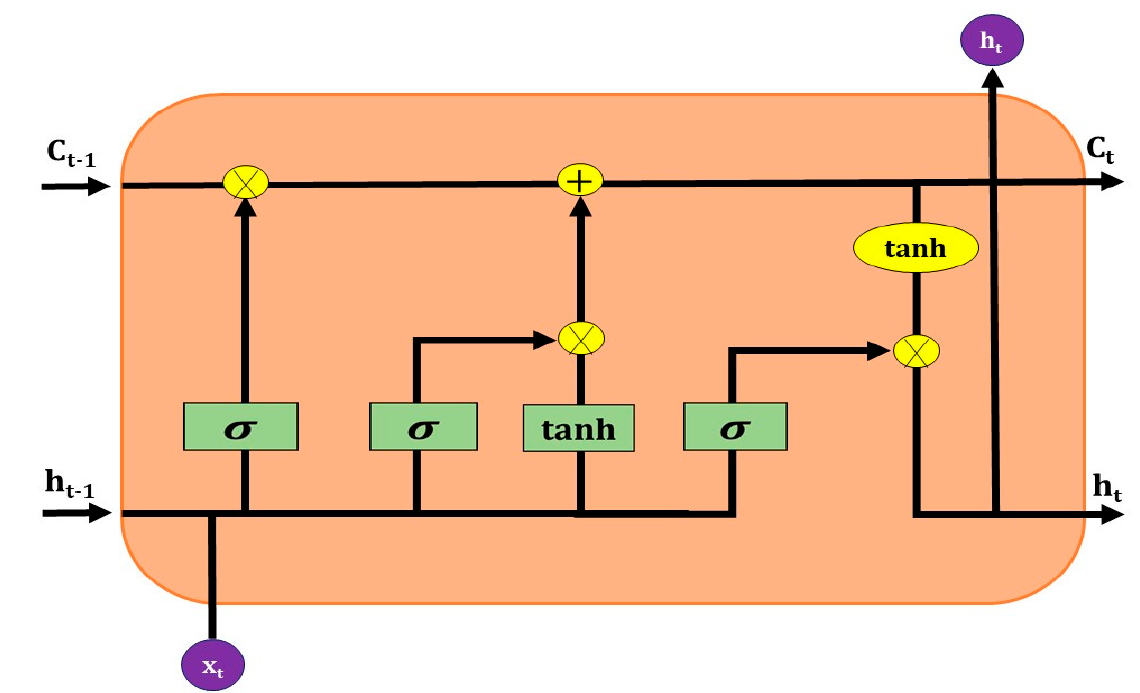
Figure 7. A basic structure of LSTM.